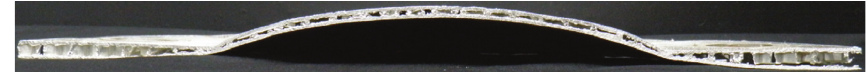
Figure 13: Cross section of sandwich panel after impulsive loading for the case of